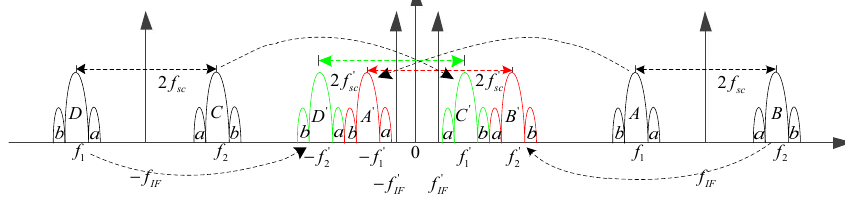
Figure 3. Spectrum transition where